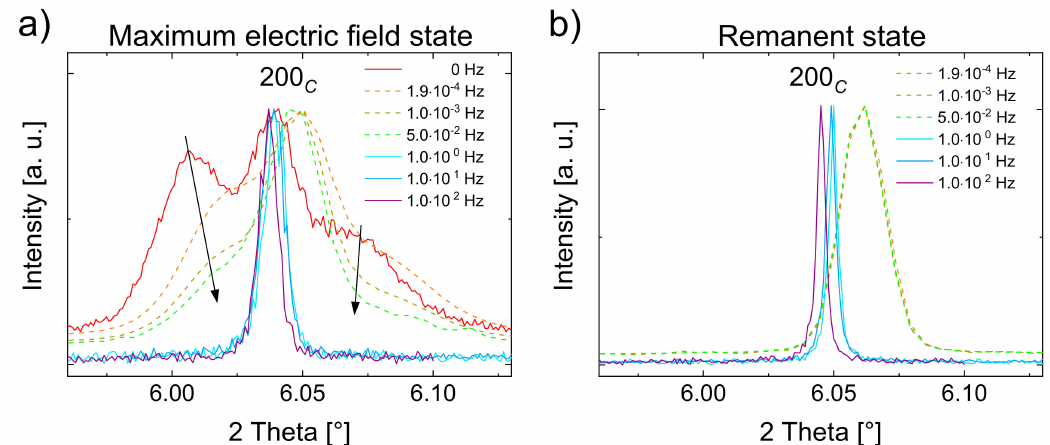
Figure 6. High-resolution (solid line) and 2D detector (dotted line, all at 0 ◦ azimuthal angle) patterns of the 200 C reflection at maximum electric field during bipolar cycling ( a ) and in the remanent state ( b ) at di ff erent frequencies from static field (0 Hz) to 10 2 Hz. To be graphically comparable, the intensities were normalized to the maximum